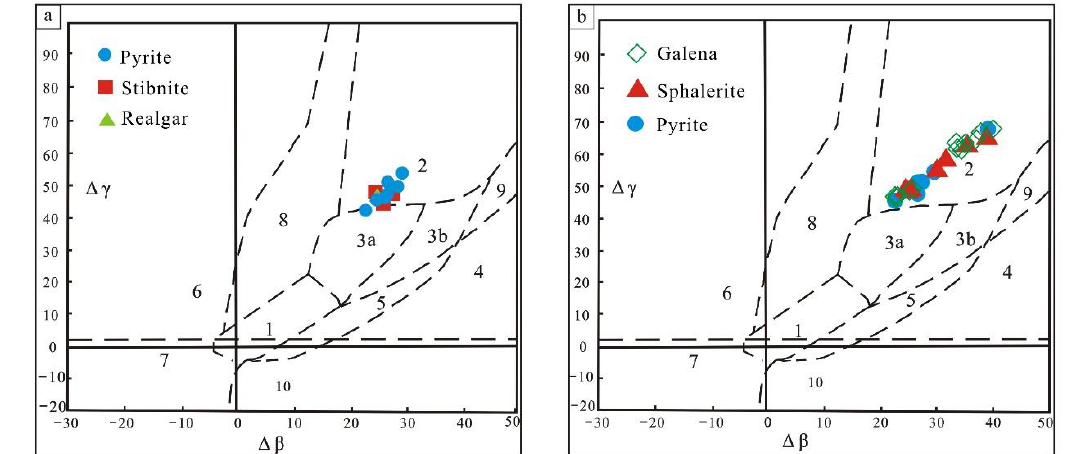
Figure 17. Plot of Δβ vs. Δγ for the Changkeng – Fuwan Au ( a )-Ag ( b ) deposit (base map is from [109]). The Pb sources are: (1) mantle; (2) upper crust; (3) (3a, magmatism; 3b, sedimentation); (4) chemical sedimentation; (5) hydrothermal sedimentation; (6) mesometamorphism; (7) deep metamorphic lower crust; (8) orogenic belt; (9) ancient shale crust; and (10) retrograde metamorphism.